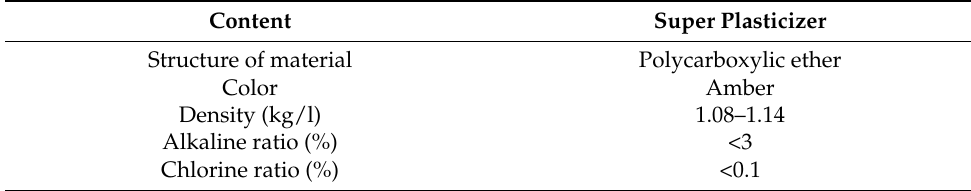
Table 3. The properties of super plasticizer.